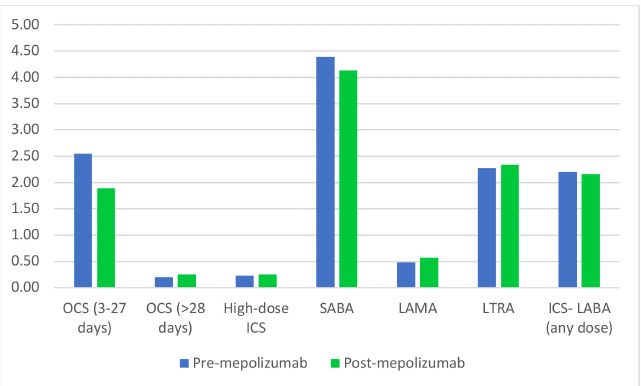
Figure 1. Mean weighted average medication dispensing before and after mepolizumab initiation. Significant differences in dispensation patterns were not detected pre- and post-